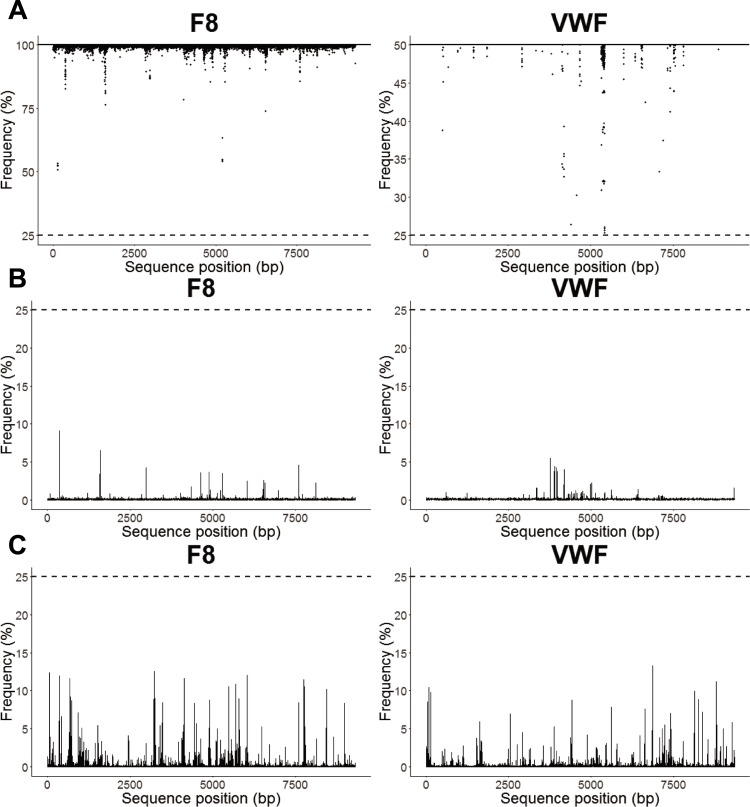
Reference allele and alternative allele/indel frequencies observed for all positions of F8 and VWF for all subjects.(A) Reference allele frequencies. Expected frequencies for hemizygote (F8) and heterozygote (VWF) positions given by solid black line. (B) Average alternative allele frequencies. (C) Average indel frequencies. Noise level limit at 25% given by dashed line.